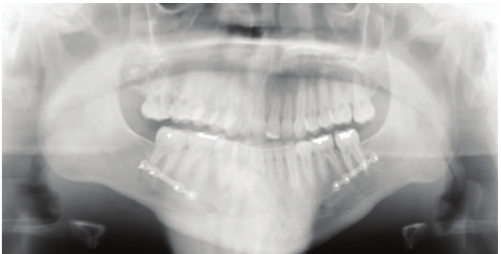
Figure 18: Stage 2: Orthodontic Treatment Final Panoramic Radio- graph.